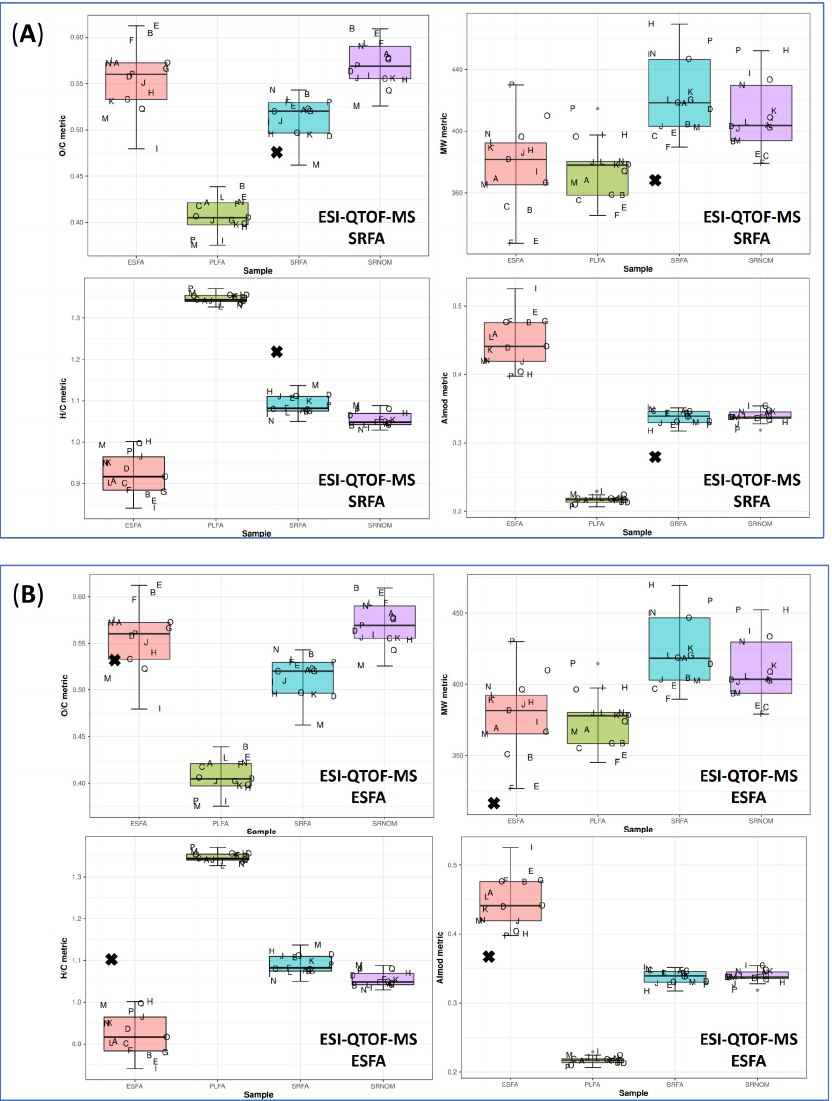
Figure 5. Box plots showing median (black horizontal line) and range (a vertical line with black bar) from the metric values (O/C wa , m/z wa , H/C wa and AI wa ) for the Elliott Soil, Pony Lake and Suwannee River IHSS fulvic acids (ESFA, PLFA and SRFA), together with the Suwannee River natural organic matter sample (SRNOM) across 17 HRMS instruments using common ions provided by InterLabStudy package version: 0.0.1.5 available online: https://go.warwick.ac.uk/InterLabStudy (accessed on 31 March 2022). The calculated metric values from the SRFA ( A ) and ESFA ( B ) analyzed by ESI-QTOF-MS are indicated with a black “X”. Instruments are indicated by their designated letters: Orbitrap-MS (A–G) and FTICR-MS (H–Q).